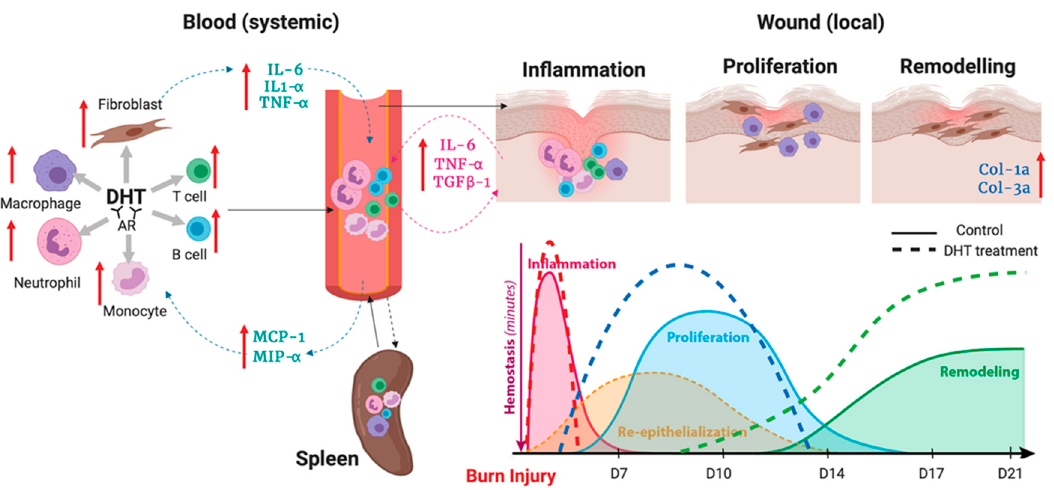
Figure 6. Illustration of DHT enhances major burn injury wound healing via accelerating inflammation turnover, resulting in a fast resolution of inflammation phase followed by early proliferation and remodelling.